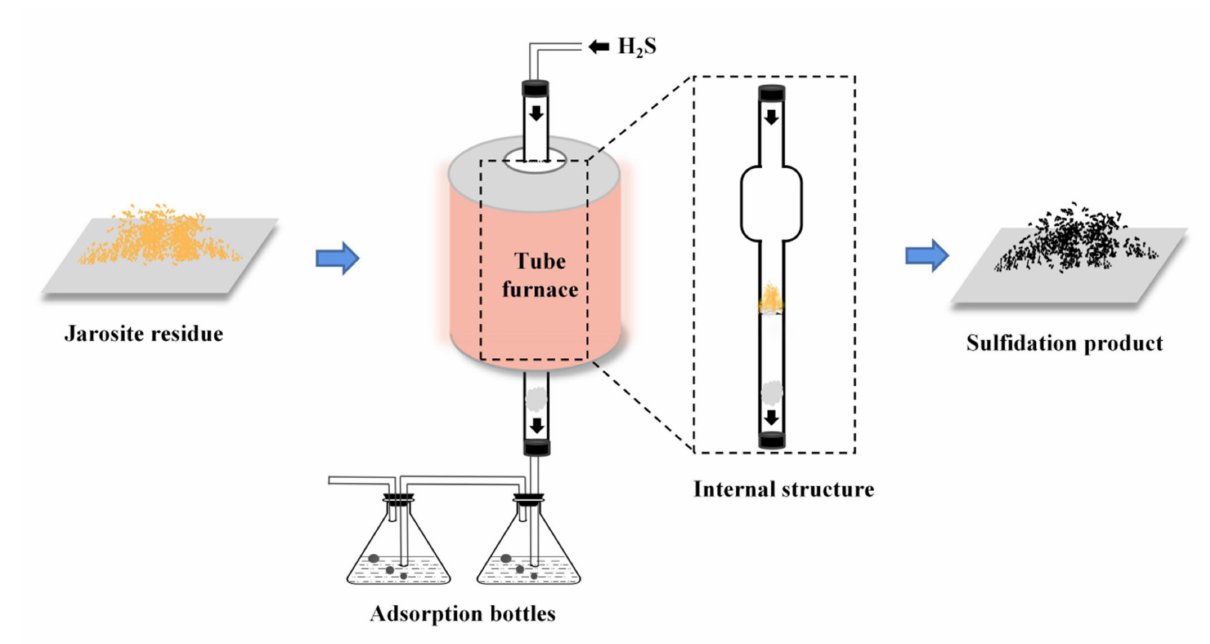
Figure 2. Sketch of the sulfidation